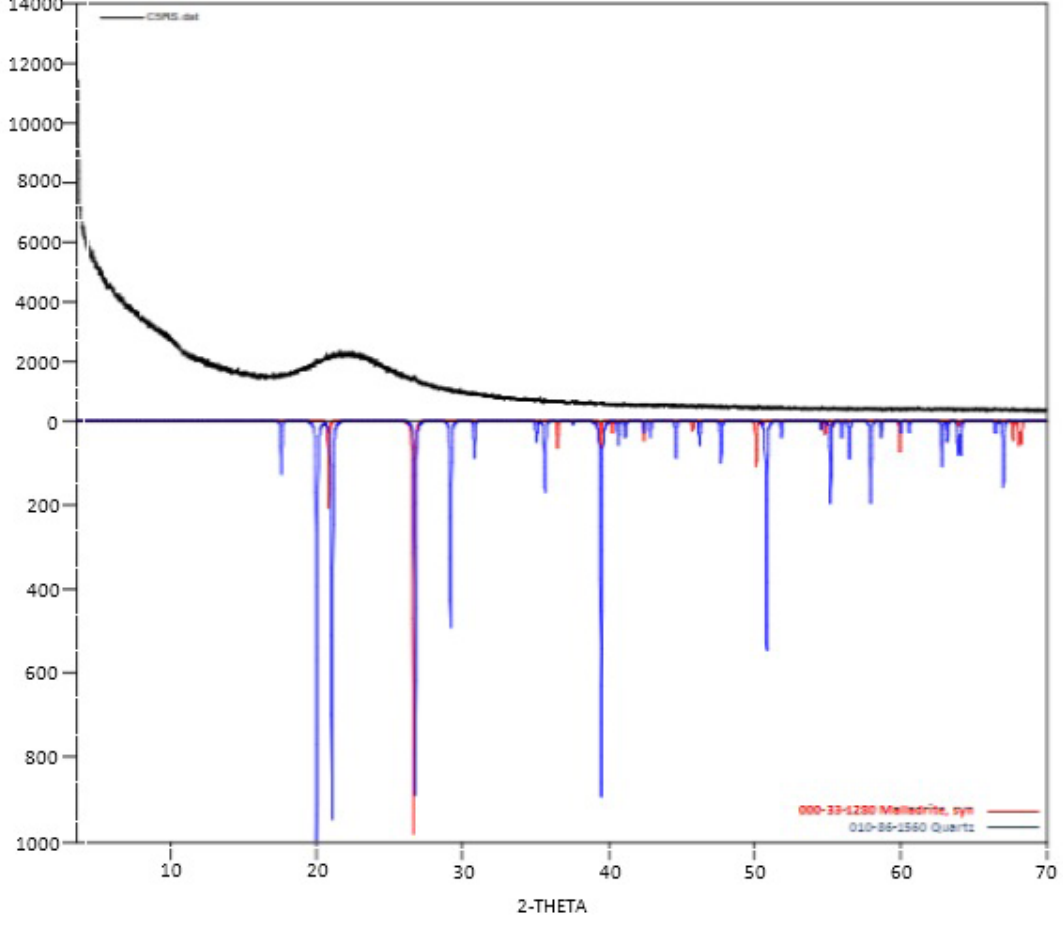
Figure 6. Diffraction profile of synthesized SiO